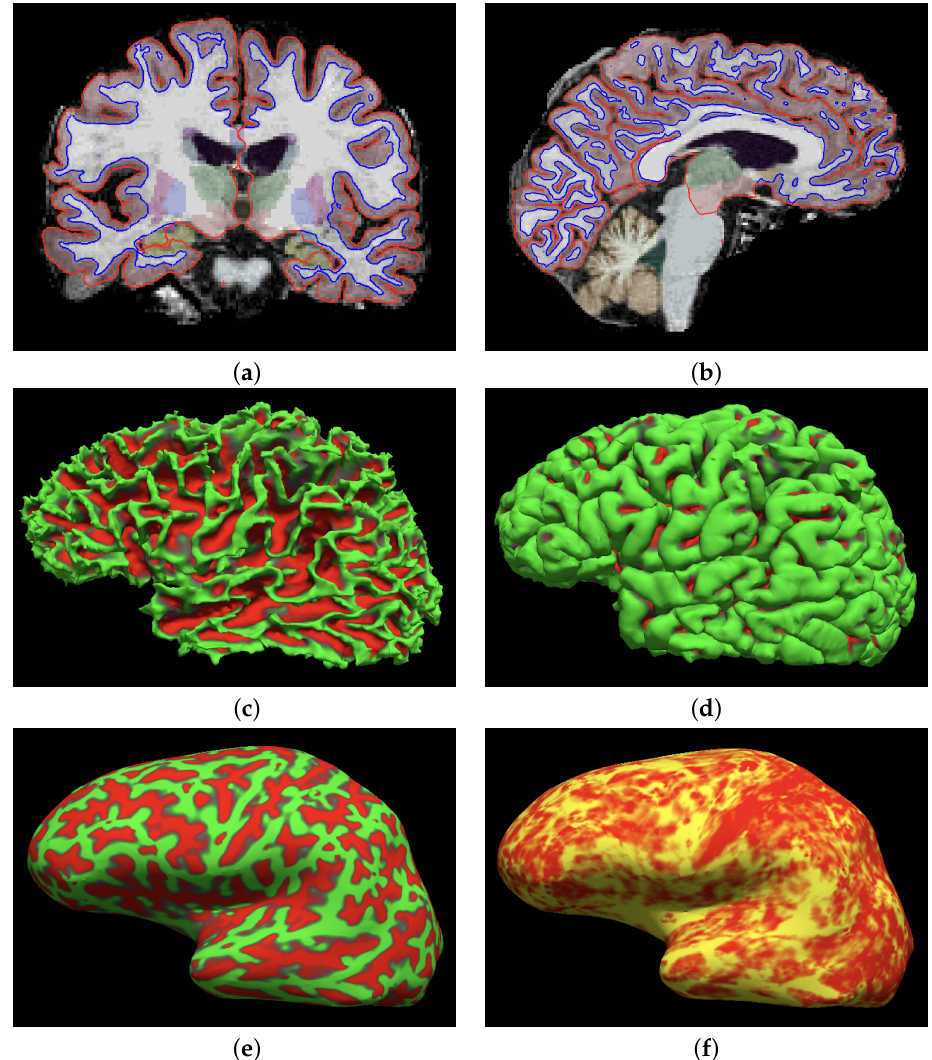
Figure 2. ( a , b ) show the coronal and sagittal segmentation results. The edge color blue indicates the demarcation of the white matter surface, and the red edge the pial surface. Plots ( c – f ) show the three-dimensional view of the surface analysis for the same subject. ( a ) Coronal view. ( b ) Sagittal view. ( c ) 3D view of white matter surface. ( d ) 3D view of pial surface. ( e ) 3D view of the inflated surface: giry (green) and sulci (red). ( f ) 3D view of the thickness map of the inflated